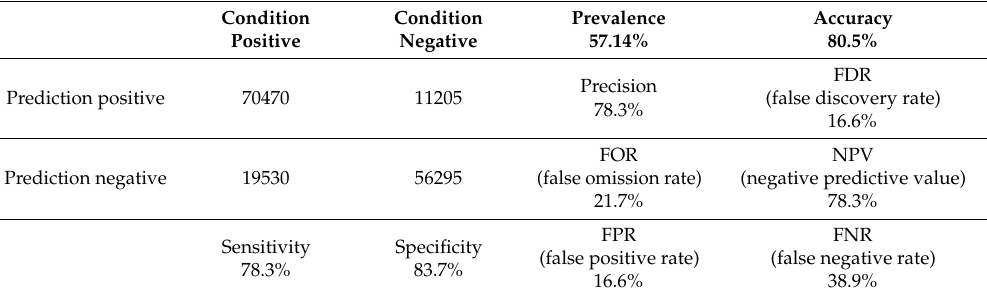
Table 1. Confusion matrix for single spectrum LDA classification (4 variables).